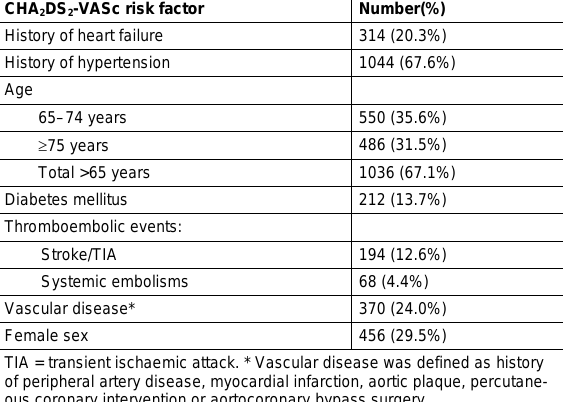
Table 2: Prevalence of CHA 2 DS 2 -VASc risk factors at baseline.